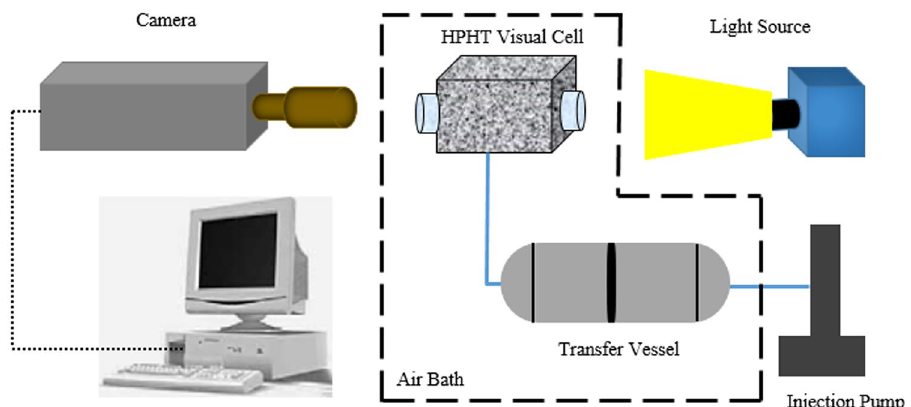
Fig. 10 Schematic of HPM method